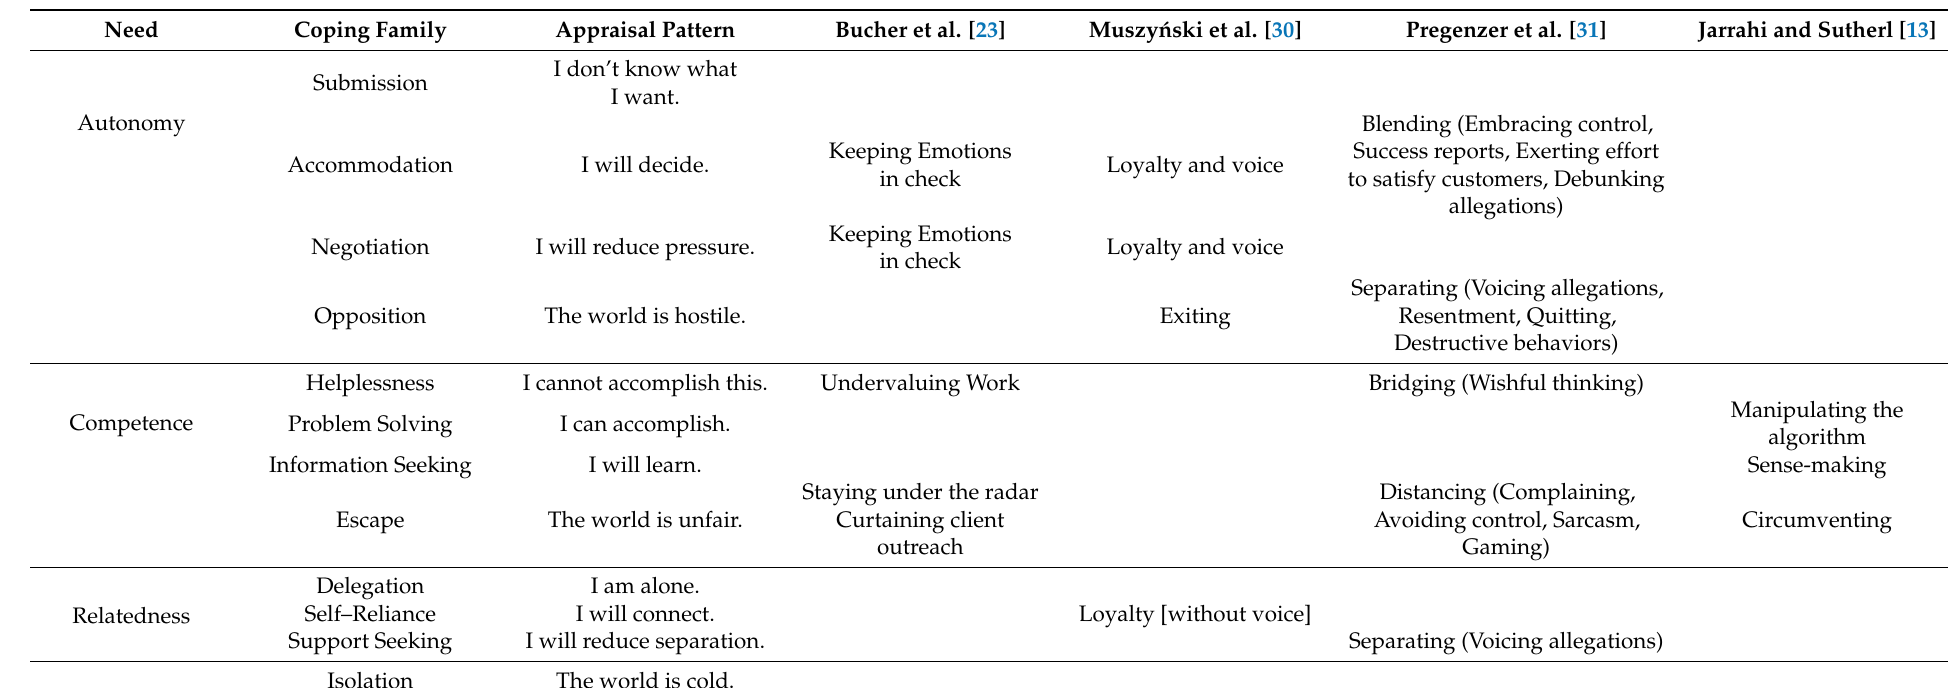
Table 2. Families of coping identified in gig-worker coping